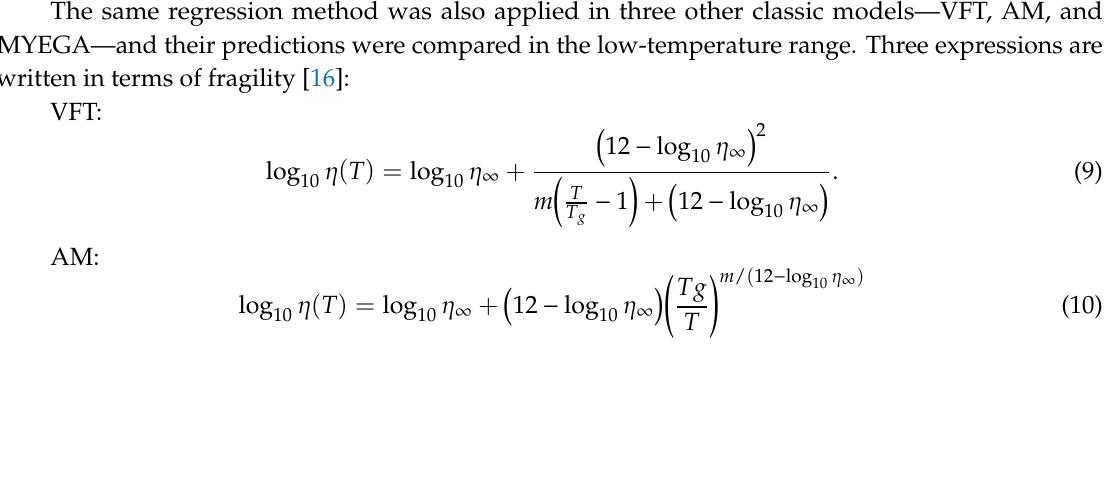
Figure 2. ( a ) Viscosity data of 7.9Cs 2 O-23.2CaO-66.7SiO 2 -1Fe 2 O 3 (the data in the red circle are for fitting); ( b ) results of the low-temperature extrapolation of the four models. Table 1. Obtained parameters of 7.9Cs 2 O-23.2CaO-66.7SiO 2 -1Fe 2 O 3 in the modified Eyring model.